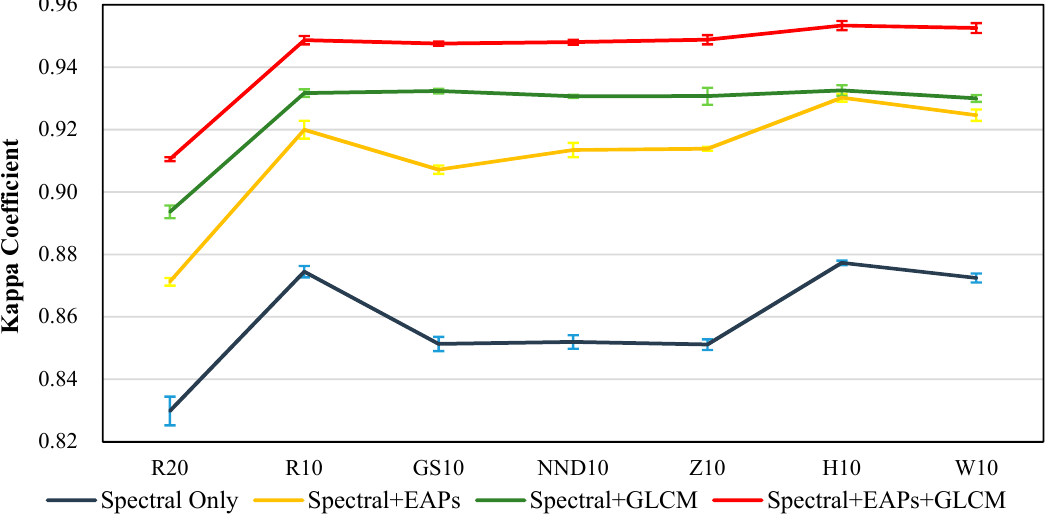
Figure 4. Kappa coefficient of seven preprocessed images on each of the feature sets.